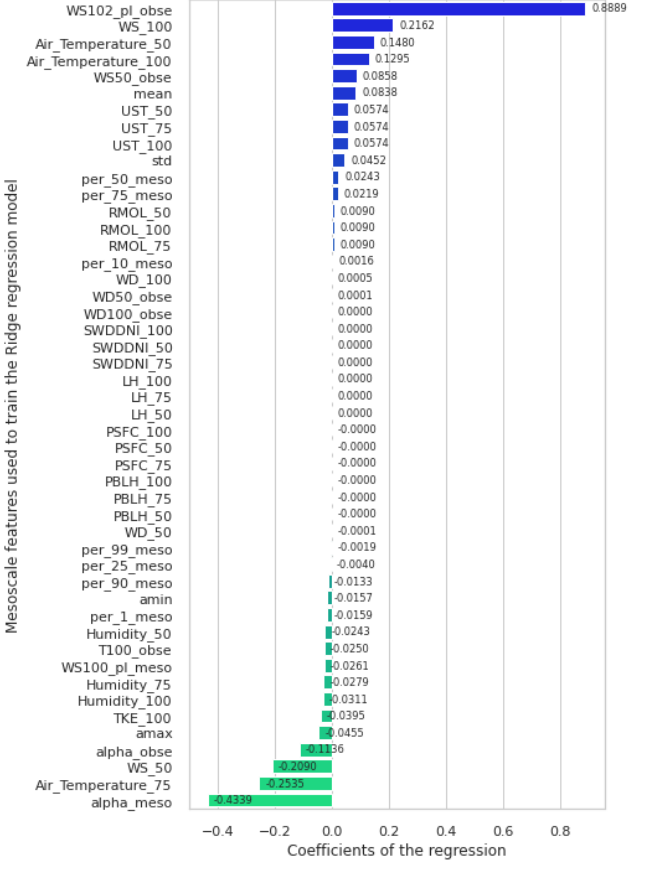
Figure 17. Feature importance for the ridge regression in Scenario